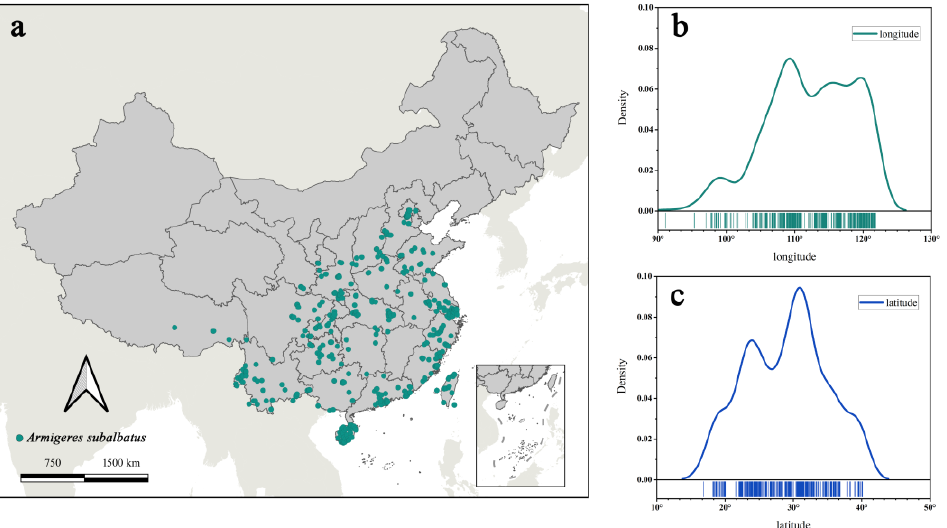
Figure 1. Overview of the observed occurrence records used for predictions. ( a ) The observed occurrence records of Ar. subalbatus in China; ( b ) longitudinal distribution curve of Ar. subalbatus habitat in China; ( c ) latitudinal distribution curve of Ar. subalbatus habitat in China.